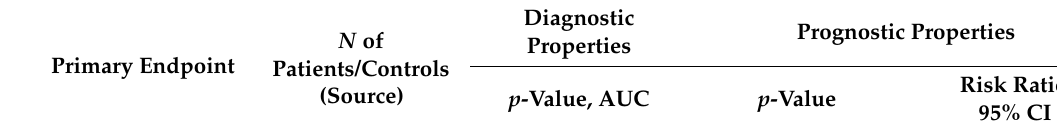
Table 1. PVT1 in lncRNA profiling studies in renal cell carcinoma. *—Papillary renal cell carcinoma; otherwise, clear cell renal cell carcinoma; **—Included patients with ccRCC, chromophobe RCC, and PRCC; and ***—Included both serum and tissue samples; otherwise, only tumor and nontumor